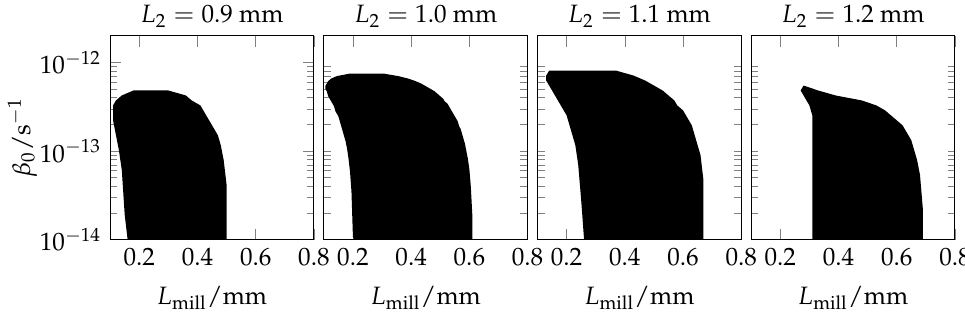
Figure 10. Stable (white) and unstable (black) regions for variations of the sieve